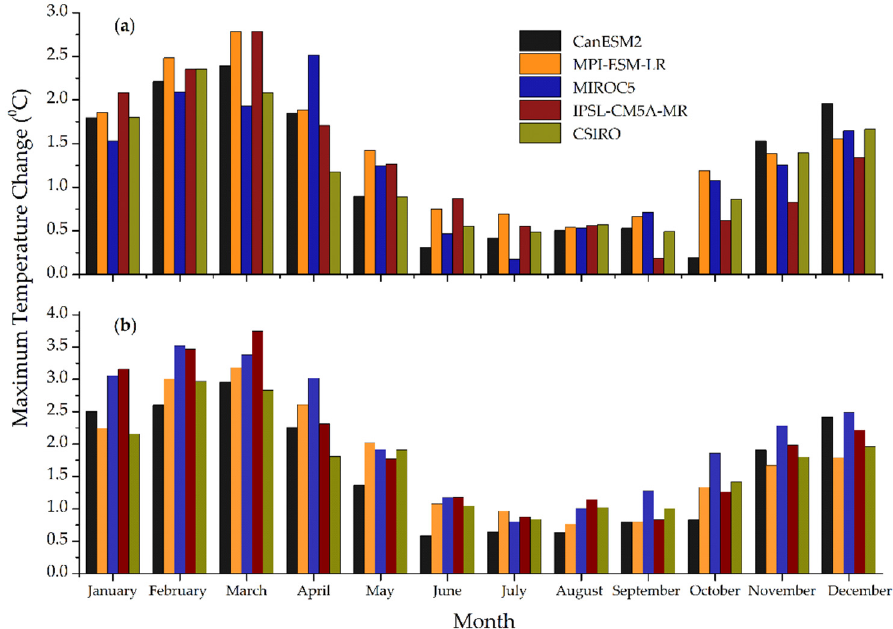
Figure 9. Changes in the monthly maximum temperature for the near future period from 2021–2050 with respect to the baseline obtained with: ( a ) RCP4.5; and ( b ) RCP8.5.